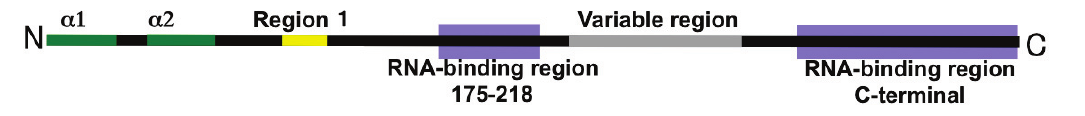
Figure 2. Schema of the central region of hantavirus N. Region 1 (aa 100-12) assists